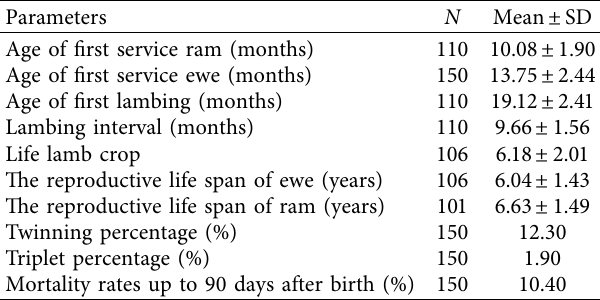
Table 4: Reproductive performance of Blackhead Somali